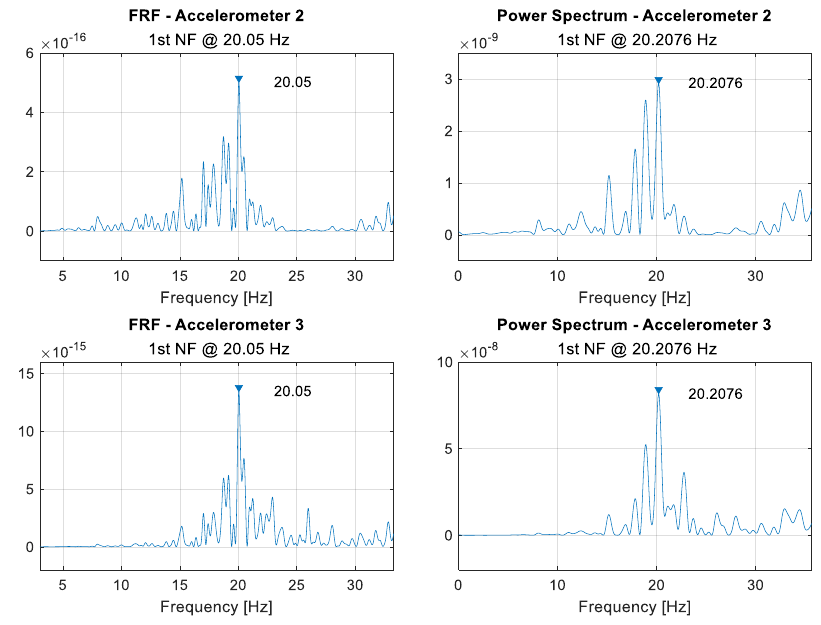
Figure A12. Arduino measurement: 3.0 revolution bolt release .